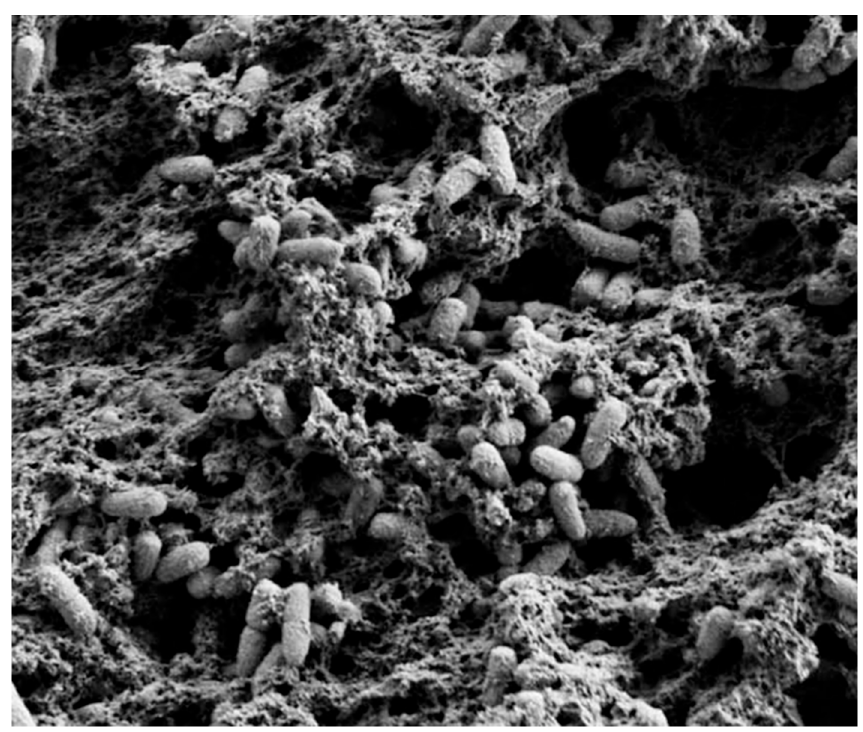
Figure 1. Scanning electron microscopy image of P. aeruginosa PA14, cultured as a pellicle. Reproduced from [24]. Copyright © 2011 Franklin et al.